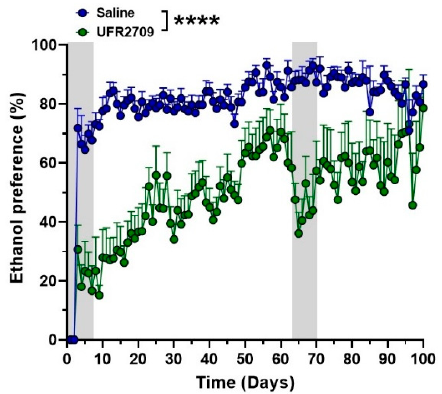
Figure 3. Preference for ethanol solution of the animals treated with UFR2709 or saline (gray bars). Ethanol preference data are expressed as mean ± SEM (g/kg/day) and represent the percentage of total daily fluid intake that was ingested from the bottle containing the ethanol solution. Two-way ANOVA with Bonferroni’s multiple comparison test was used to analyze the effect of UFR2709 treatment on ethanol preference. **** p <